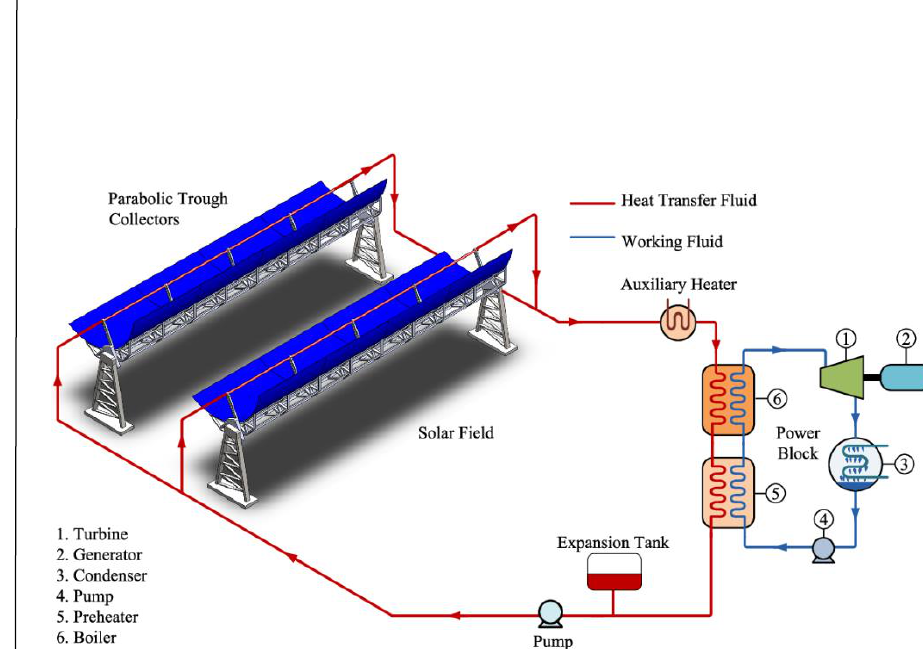
Figure 2 – Solar plant with parabolic troughs (Vasquez Padilla, 2011) Рис. 2 – Солнечная электростанция с параболическими коллекторами (Vasquez Padilla,